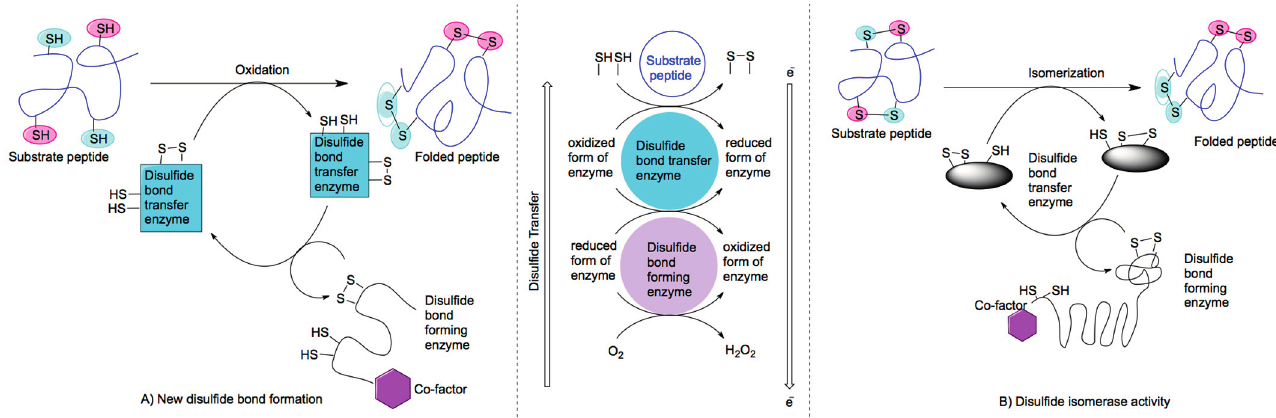
Figure 1. Schematic representation of general mechanisms by which a disulfide bond is formed by an intra-cellular enzyme-cofactor system: ( A ) Formation of new disulfide bonds; and ( B ) reshuffling of existing bonds by isomerase